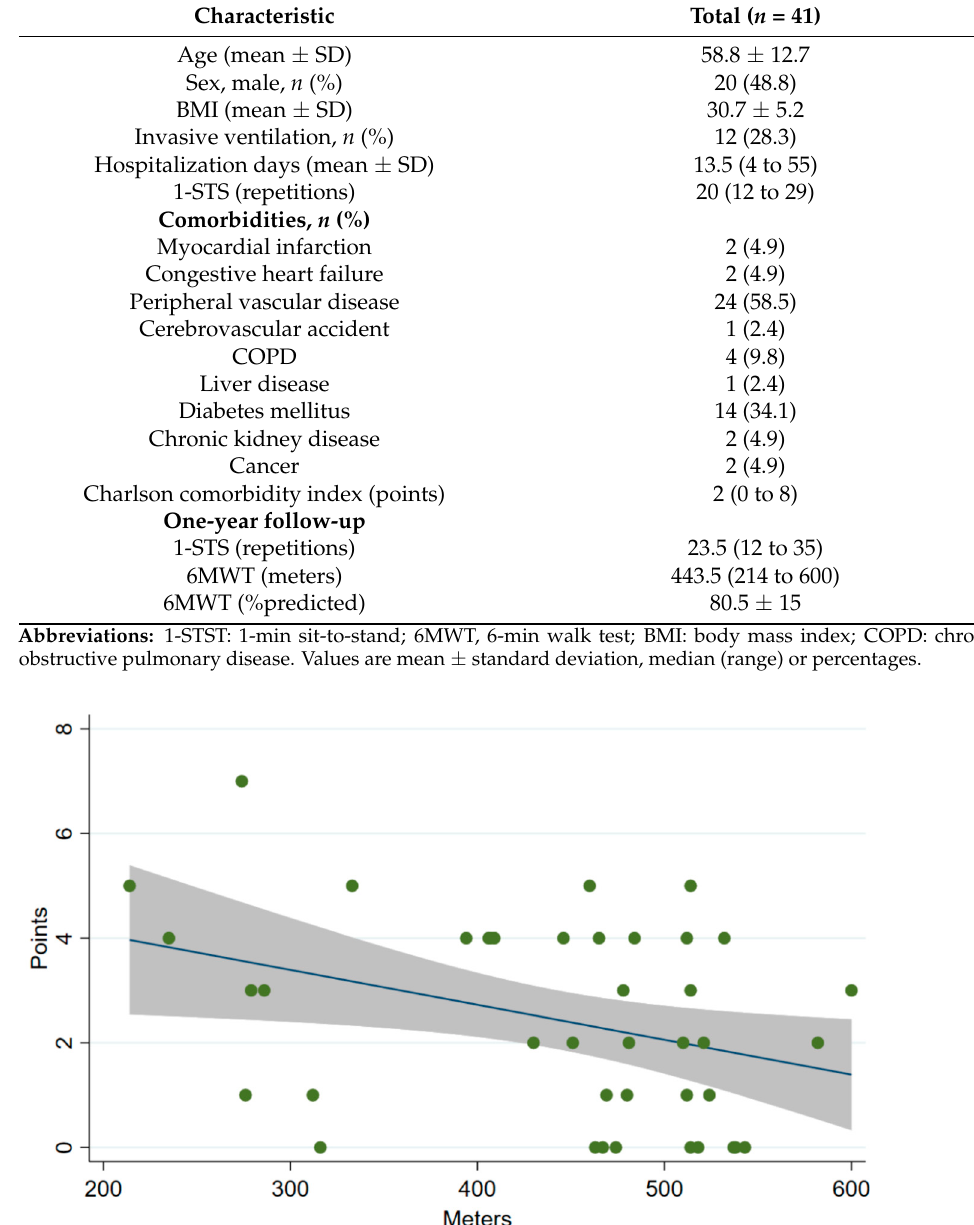
Table 1. Patient characteristics.